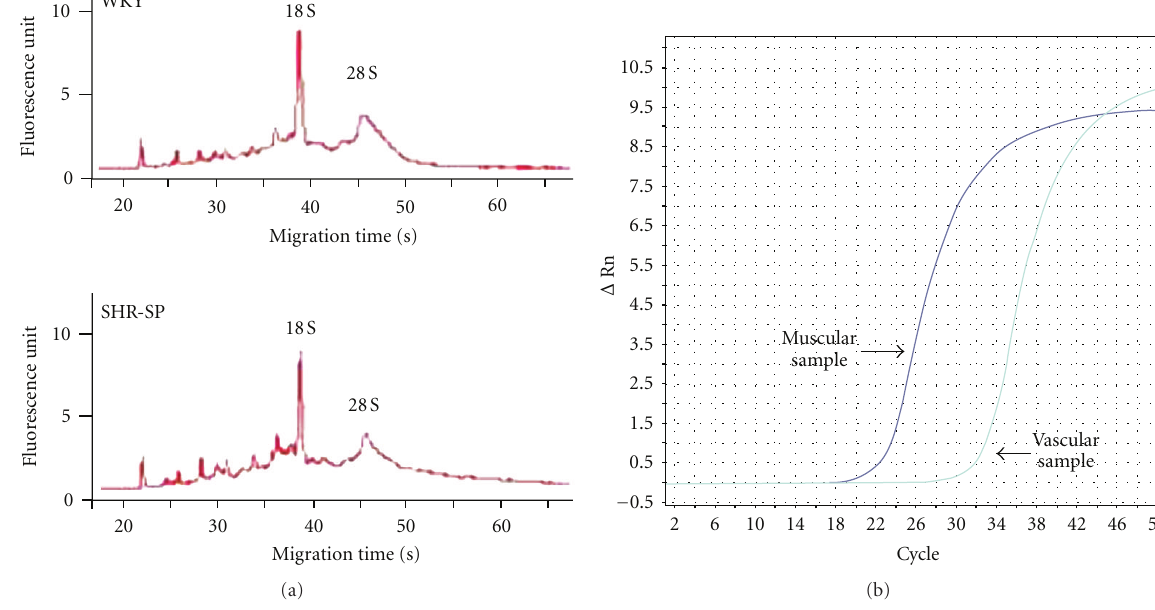
Figure 2: (a) Representative RNA electrophoregrams of the muscular samples of WKY (top) and SHR-SP (bottom). (b) Representative amplification plots of BNP mRNA in the muscular and vascular samples of